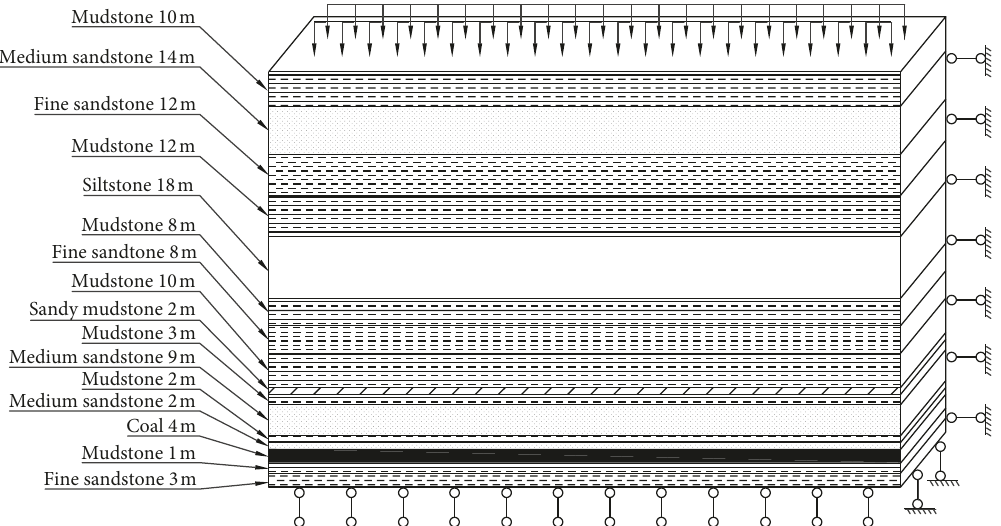
Figure 6: Numerical analysis model and basic